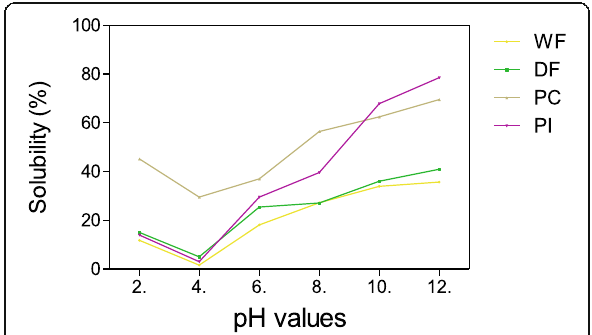
Fig. 1 Protein solubility of okra seed whole flour, defatted flour, protein concentrate and